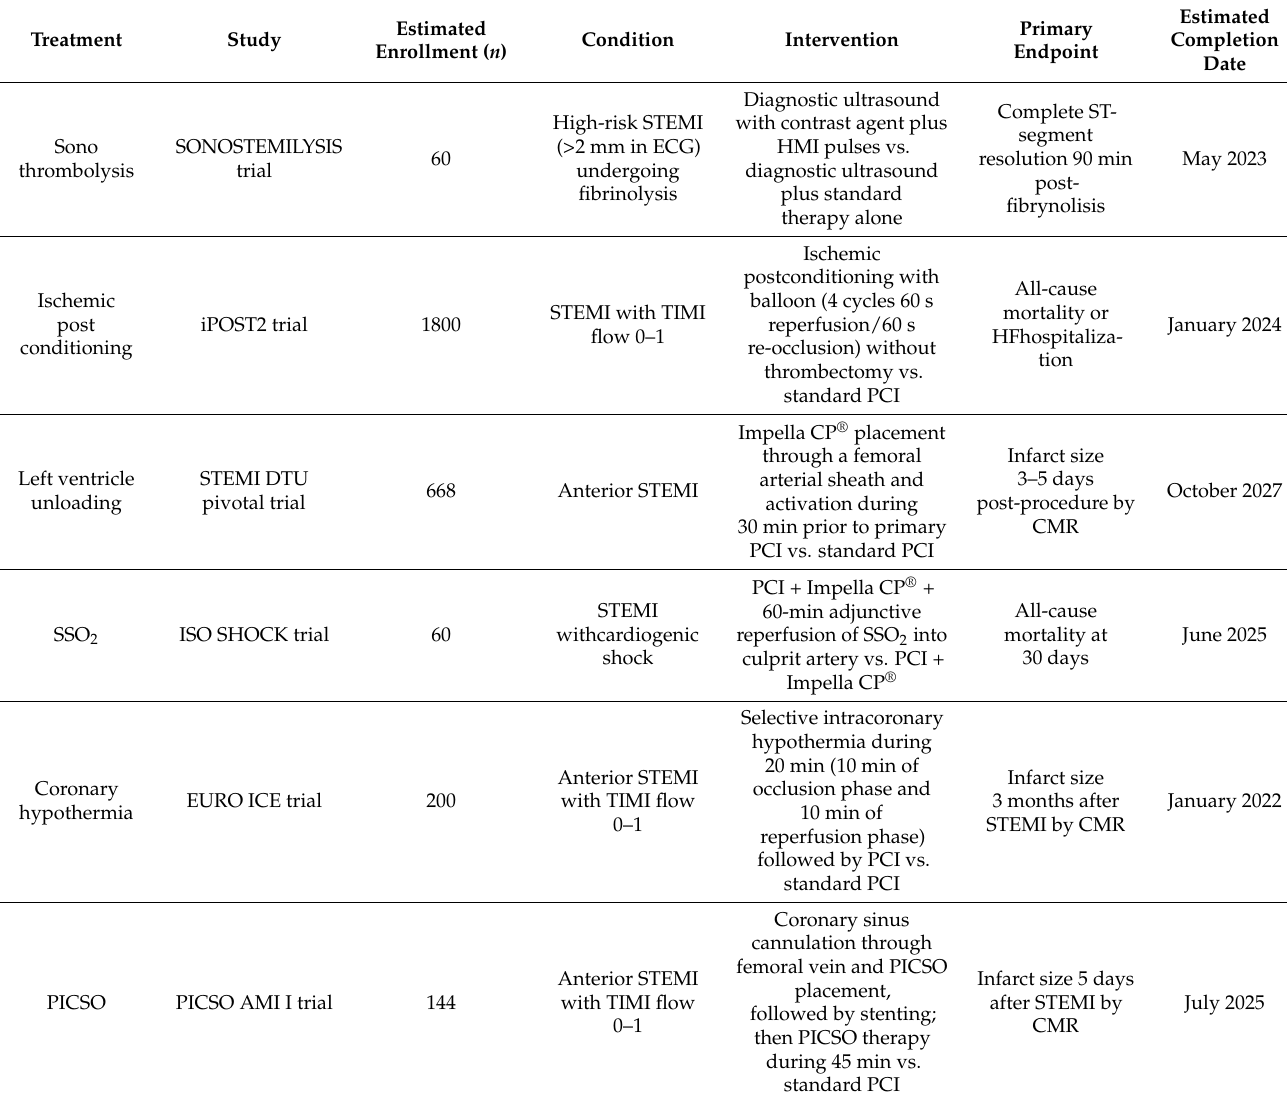
Table 2. Major ongoing clinical trials investigating novel therapeutic strategies in STEMI